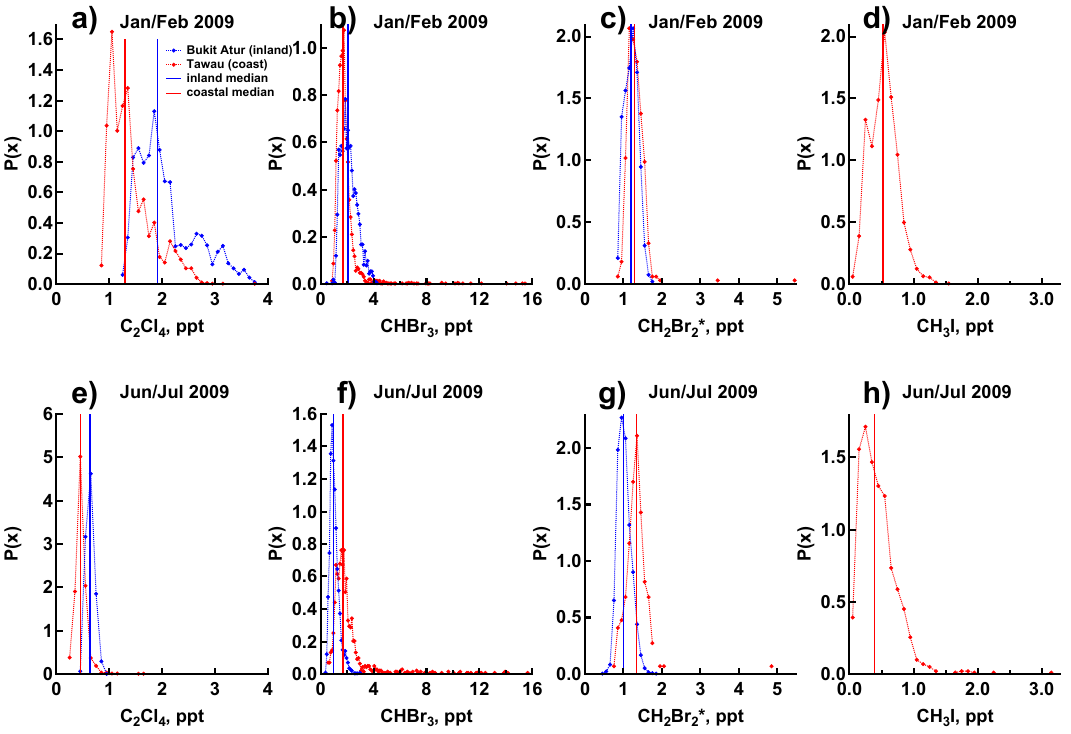
Figure 5. Probability distributions and median values at each site for January/February 2009 (merged) for (a) C 2 Cl 4 , (b) CHBr 3 , (c) CH 2 Br ∗ and (d) CH 3 I (Tawau only) and June/July 2009 (merged) for (e) C 2 Cl 4 , (f) CHBr 3 , (g) CH 2 Br ∗ distributions are shown as blue circles with dotted blue lines and Tawau distributions as red circles with dotted red lines. Median values for inland Bukit Atur are shown by solid vertical blue bars and for coastal Tawau by solid vertical red bars. The bin width for each probability distribution is 0.1ppt, and the area under each curve is equal to 1 (probability of 1). High values beyond the scale of the x axis are not shown; for instance the high tail is not wholly visible for CHBr 3 at Tawau (b, f) , though all data are included in the box-and-whisker plots (Fig. 4).